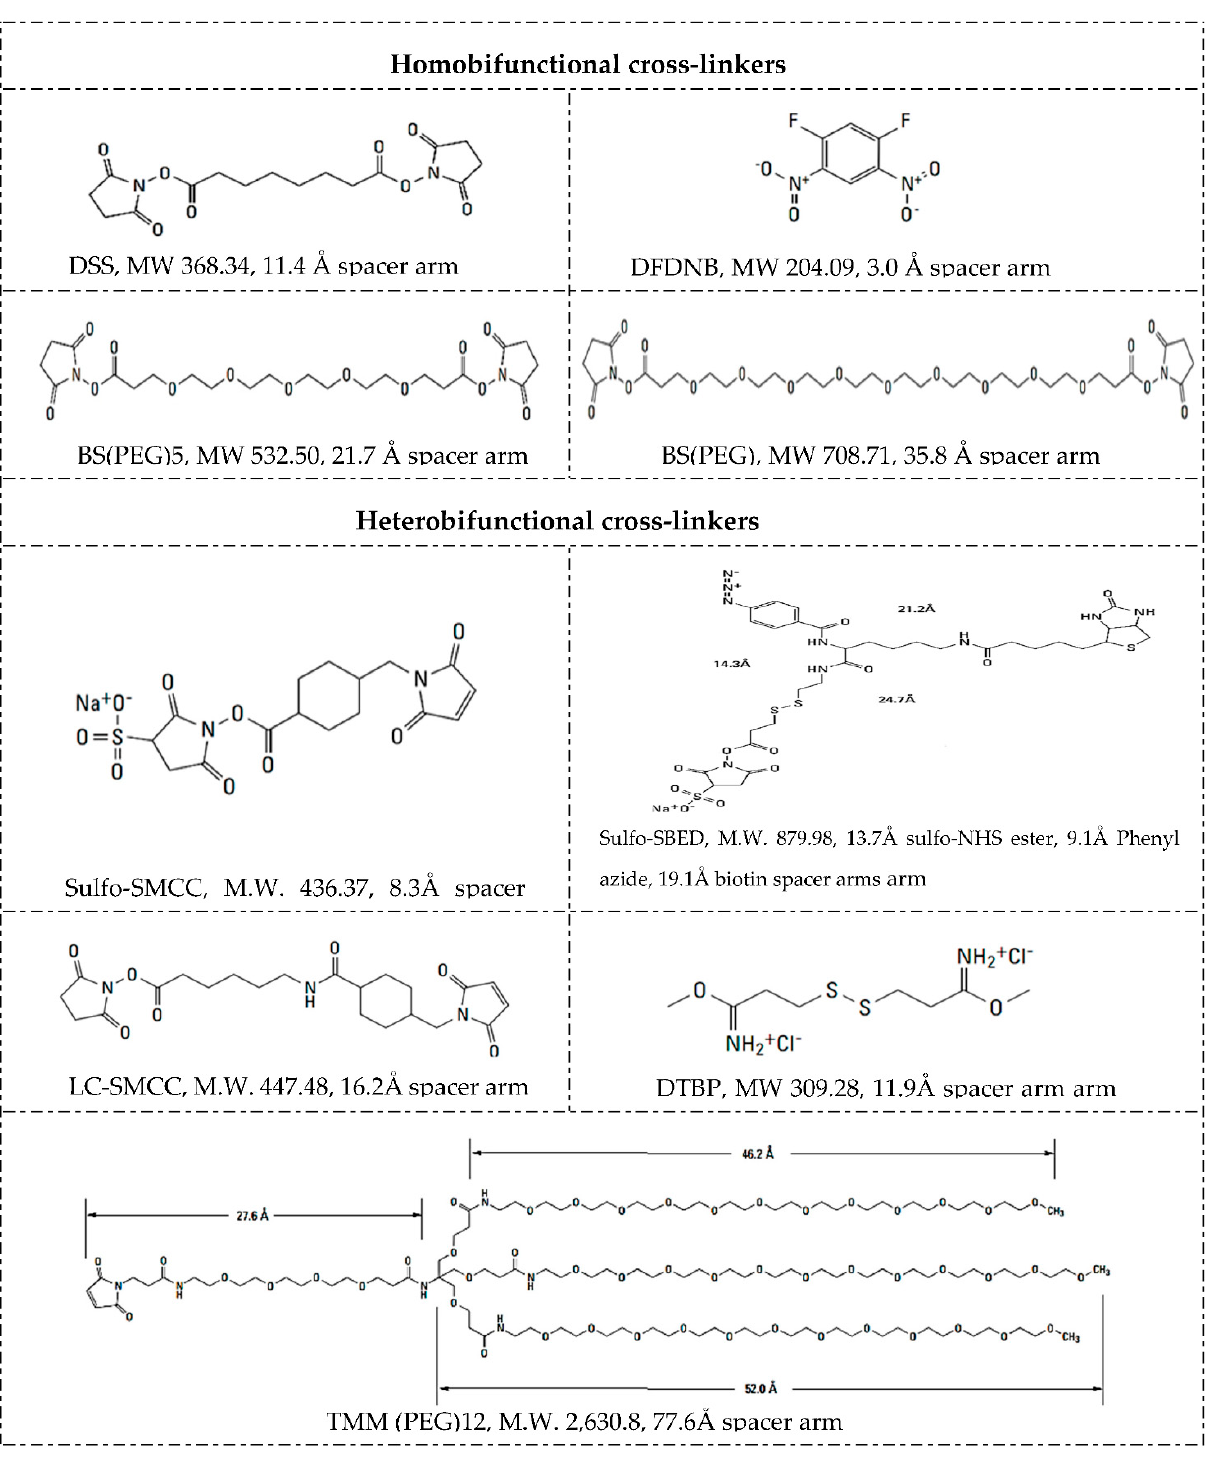
Figure 3. Structures and characteristics of some cross-linkers. The chemical chain between two reactive groups is called the spacer arm, whose length can go from zero-length to >100 angstroms, determining how flexible the linking will be. Longer spacer arms are more flexible and reduce steric hindrance but have more potential sites for nonspecific binding. For example, length spacer arms of 1,5-difluoro-2,4- dinitrobenzene (DFDNB), disuccinimidyl suberate (DSS), bis(succinimidyl)